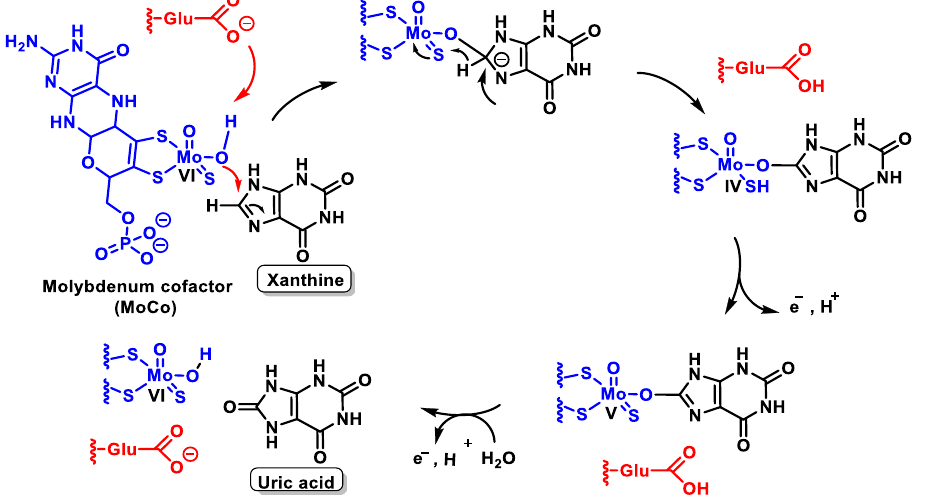
Figure 8. Possible mechanism by which XOR converts xanthine to uric acid. Catalysis is initiated by base-assisted nucleophilic attack of the equatorial Mo-OH at the C-8 carbon of xanthine with hydrogen transfer from C-8 to MoS and moves from Mo=S to Mo-SH, which simultaneously results in the reduction of Mo(VI) to Mo(IV). Reoxida- tion of the molybdenum centre occurs by electron transfer to the other redox active sites of the enzyme, accompanied by deprotonation of the Mo- SH bond and cleavage of the bound product by hydroxide from the solvent to regenerate the Mo-OH group. The peroxisome contains different proteins that can generate H 2 O 2 , such as urate ox- idase, 1- α -hydroxyacid oxidase, and D-amino acid oxidase. Peroxisomes are very common cytoplasmic organelles in the form of vesicles with a single membrane found in most eukaryotic cells. They are an oxidative organelle in which molecular oxygen serves as a co-substrate for the formation of hydrogen peroxide. Perox- isomes are named for their ability to produce hydrogen peroxide [29]. In addition, some microorganisms such as bacteria and mycoplasmas release hydrogen peroxide, which can cause damage to the host at the cellular level due to its ability to penetrate biological mem- branes. Although urate oxidase is present in almost all living organisms, bacteria, fungi, plants, and animals, it is absent in many primates and in humans. In the human genome, there is a gene for urate oxidase that has been rendered non-functional by two mutations. Since urate oxidase is missing, uric acid is the end product of purine catabolism in humans [30,31]. Unlike other animals, humans do not have the enzyme urate oxidase [31] that con- verts uric acid to allantoin, a very soluble biomolecule, so they cannot break down excess uric acid, which is very poorly soluble. As a result, urate, which makes up most of the uric acid in the blood, is transported by plasma proteins such as albumin and alpha-globulins [32], Figure 9. The enzyme urate oxidase converts uric acid into allantoin. Previously, this metabolic pathway was thought to be carried out by a single enzyme, urate oxidase, but recent research has shown that two other enzymes are involved in this